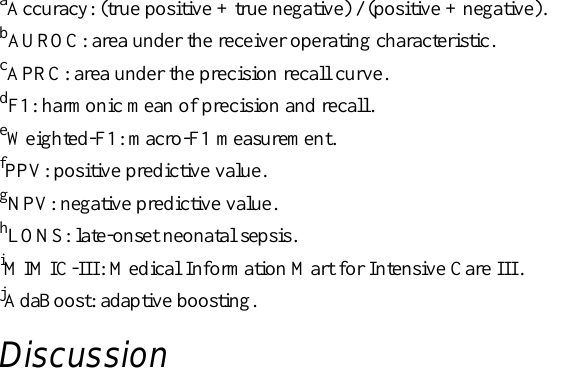
Proposed optimization algorithm LONS h prediction model (MIMIC-III)